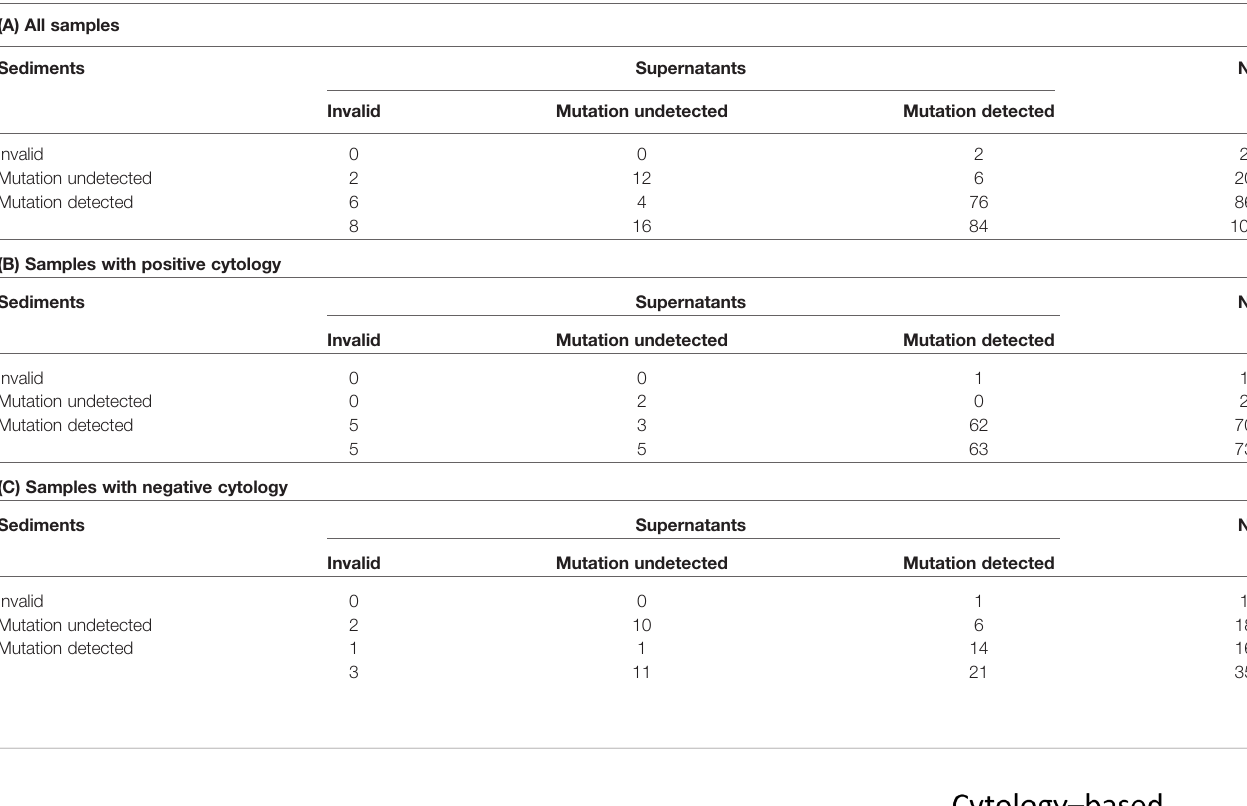
TABLE 4 | EGFR mutation status by sediments and supernatants by cytology.